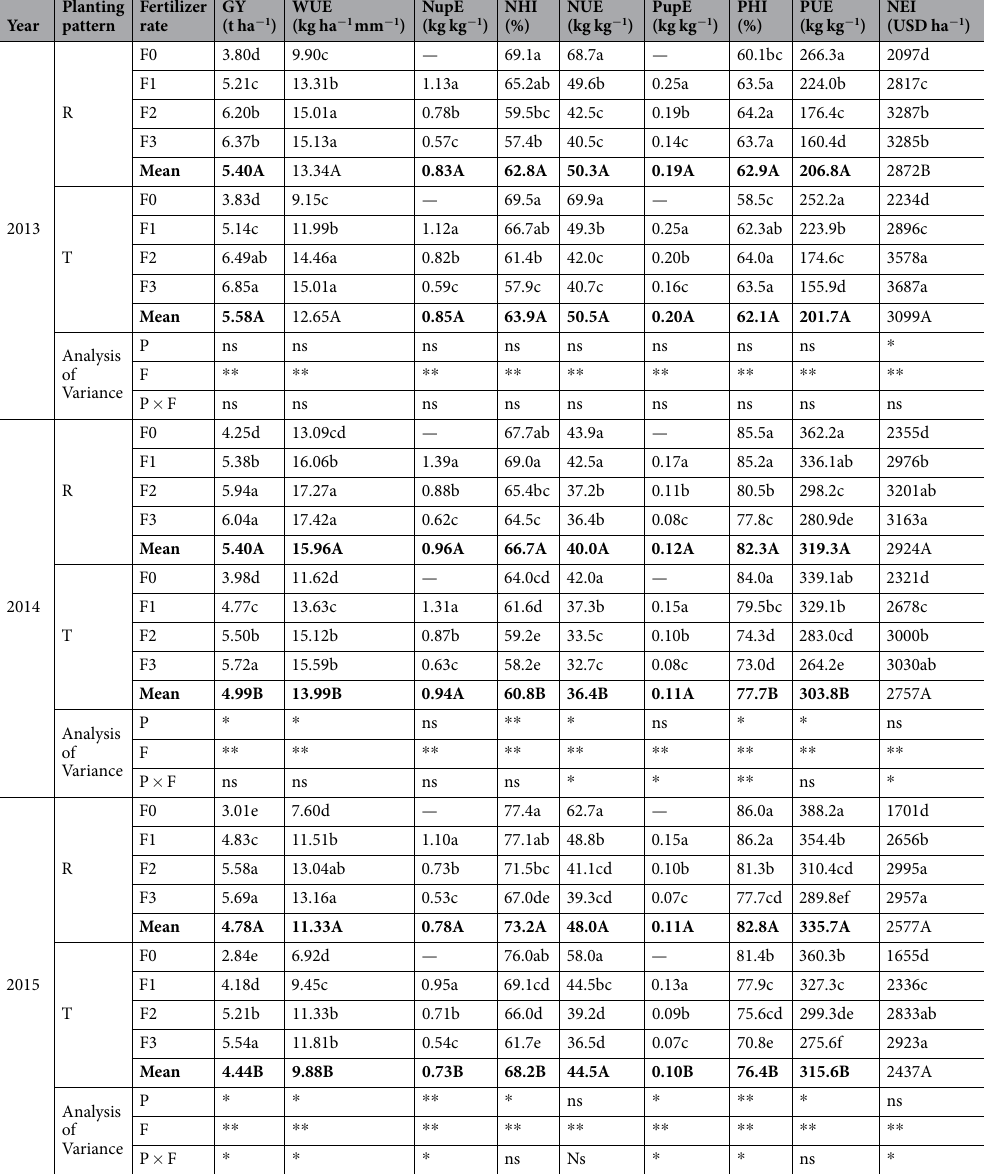
Table 4. Effects of planting pattern and fertilizer rate on the grain yield (GY), WUE, N and P uptake efficiency (NupE and PupE), N and P use efficiency (NUE and PUE), N and P harvest indices (NHI and PHI), and net economic income (NEI) for foxtail millet during 2013–2015. Note: (1 USD = 6.855 Chinese yuan, Bank of China,